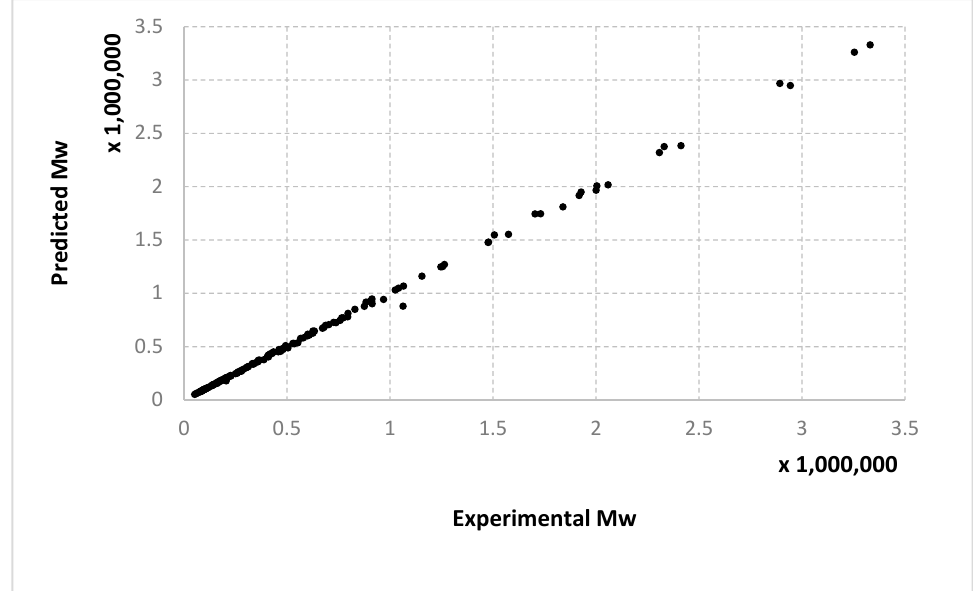
Figure 11. Predicted gravimetrical average molecular weight with the LMNNR-EA algorithm versus experimental data, setting 1, with data split into 90% for training and 10% for testing. Very similar outcomes are encountered for the M w output and the LMNNR-EA al- gorithm (i.e., Algorithm 1). However, in this case, the dispersion of the graph for the 10%–90% split is less than those for x an M n . This is in fact an indicator about the mini- mum amount of training information needed in order to generalize well.